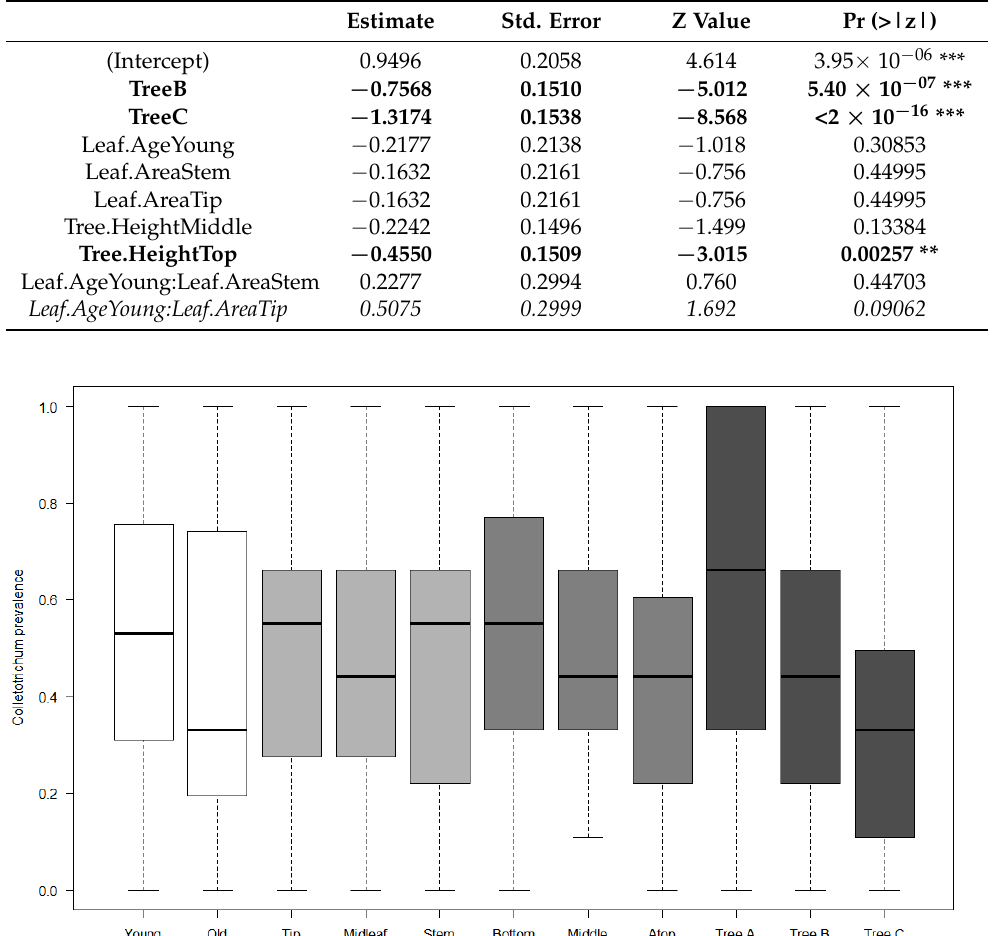
Figure 1. Global prevalence of Colletotrichum gloeosporioides for leaves and tree factor levels. Each level is illustrated with its own color: in white, leaf age (young vs. old leaves); in light grey: location on leaf (tip area, mid-leaf, near the stem); in grey: tree height (bottom, middle, and top of tree); in dark grey: individual tree variation (trees A, B, and C). Only trees and top of tree are significantly different within factor class, other factors are shown for pattern illustration purposes.